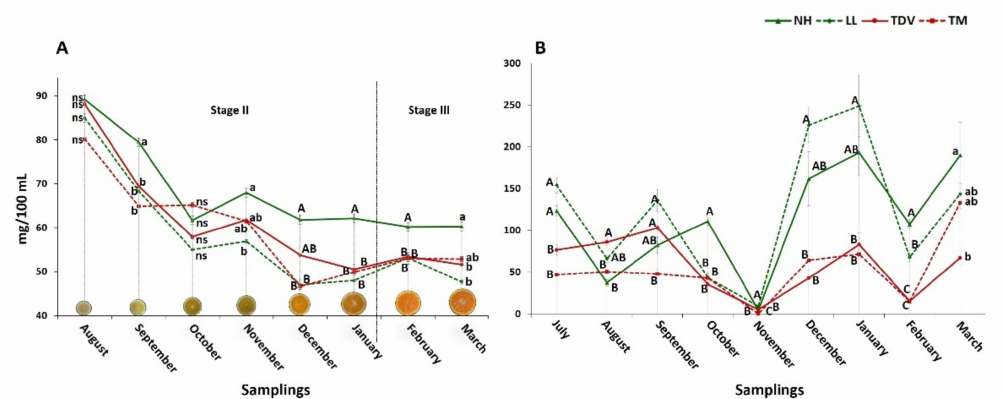
Figure 2. Trend of AsA concentration during sampling (August/March) in the fruit ( A ) and leaves (July/March) ( B ) of the four analysed varieties (Lanelate (LL), Tarocco Meli (TM), Newhall (NH), and Tarocco TDV (TDV)). The data are the mean ± S.E. of at least three replicates. Lowercase letters indicate p ≤ 0.05; uppercase letters indicate p ≤ 0.01. Oranges in ( A ) show the development and ripening of Newhall oranges; stage II and III are in according to Bain